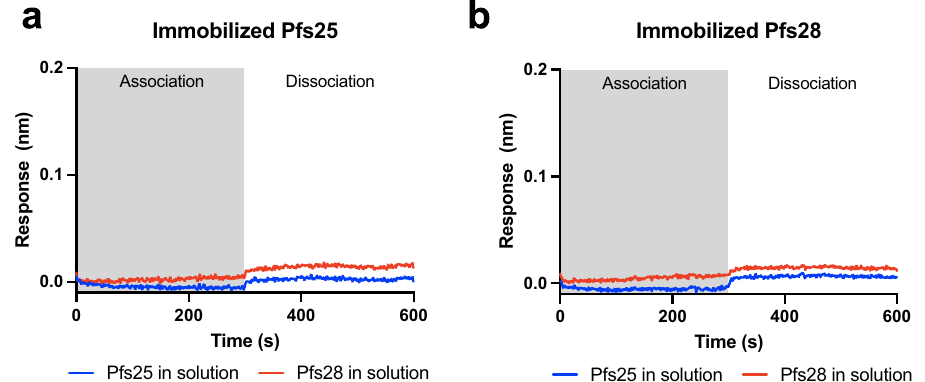
Figure 6. Pfs28 does not interact with Pfs25 by BLI. Binding curves of biolayer interferometry experiments using Pfs25 and Pfs28. Curves represent the association and dissociation of Pfs25 (blue) and Pfs28 (red) (600 nM) to sensors loaded with ( a ) Pfs25 or ( b )